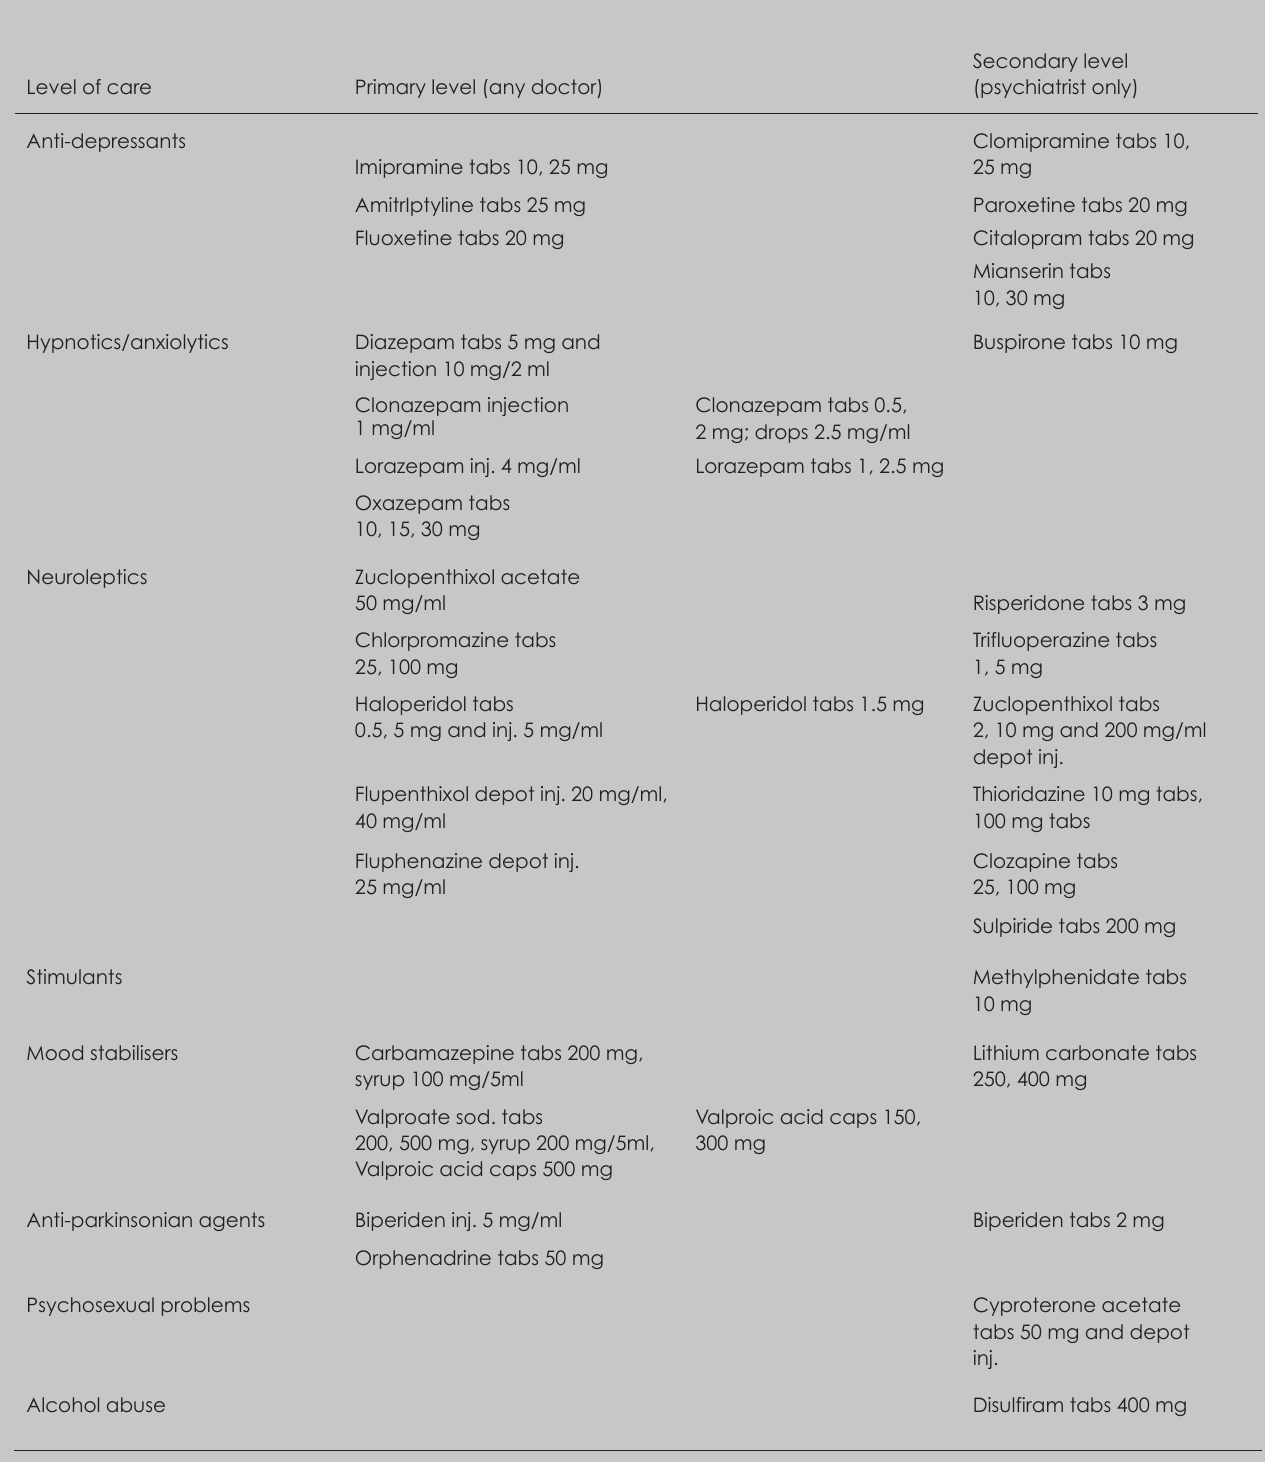
Table IV. Expanded EDL for community psychiatry in